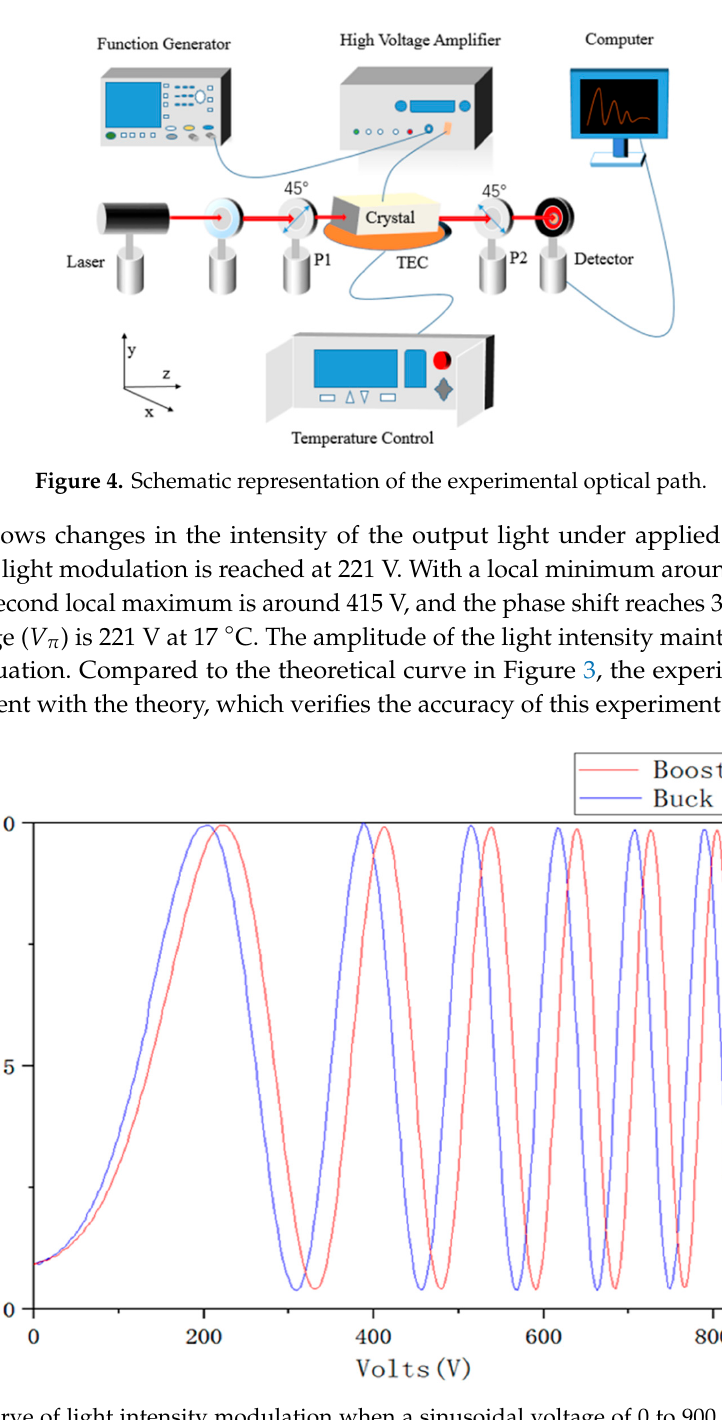
Figure 3. Theoretical curve calculated and simulated by the effective electro-optic coefficient.